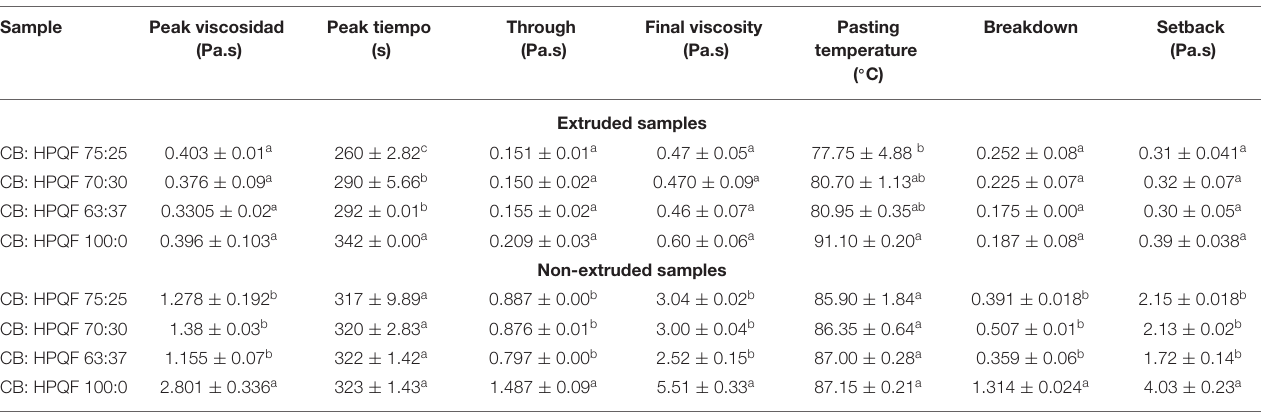
For each parameter, different letters indicate significant differences at p <